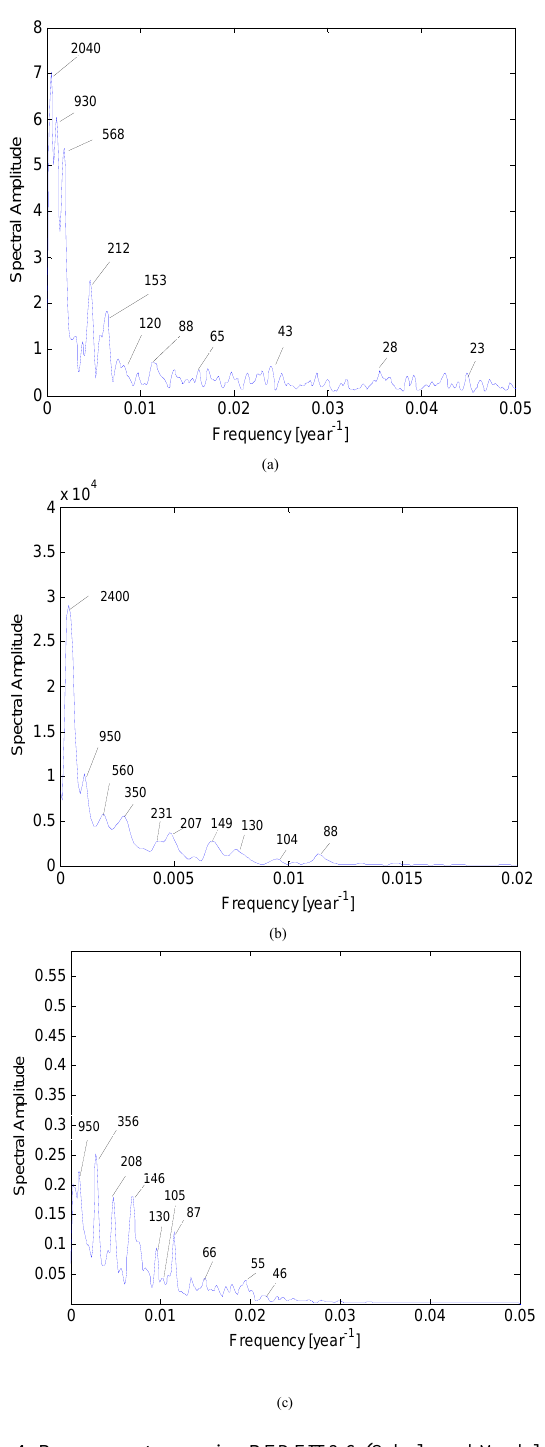
Fig.4 Fig. 4. Power spectrum using REDFIT3.6 (Schulz and Mudelsee, 2002) for δ 18 O (a) , 1 14 C (b) and 10 Be (c) records. Default pa- rameters are used except that the parameter of n 50 representing the Welch’s overlap segment averaging is 4 and Welch spectrum win- dow is chosen (refer to Schulz and Mudelsee, 2002 for details).